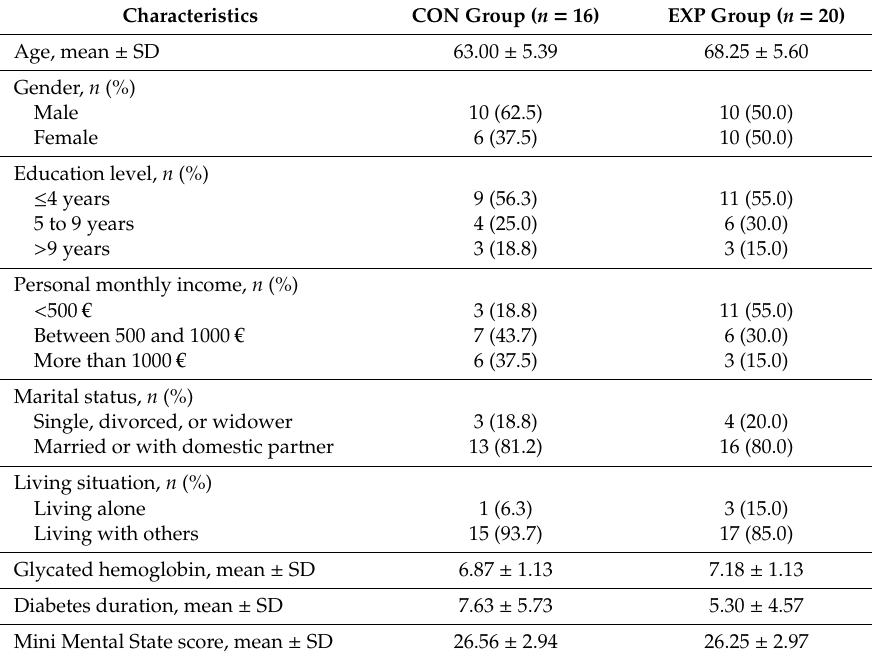
Table 4. Characteristics of the study participants according to group.